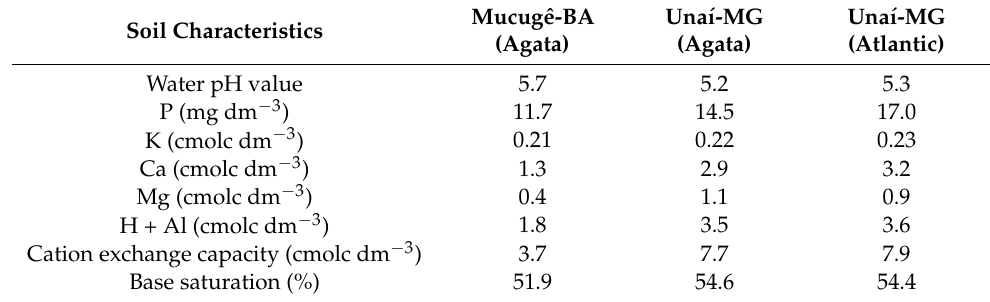
Table 1. Soil chemical characterization before planting and before fertilization (BA: Bahia; MG: Minas